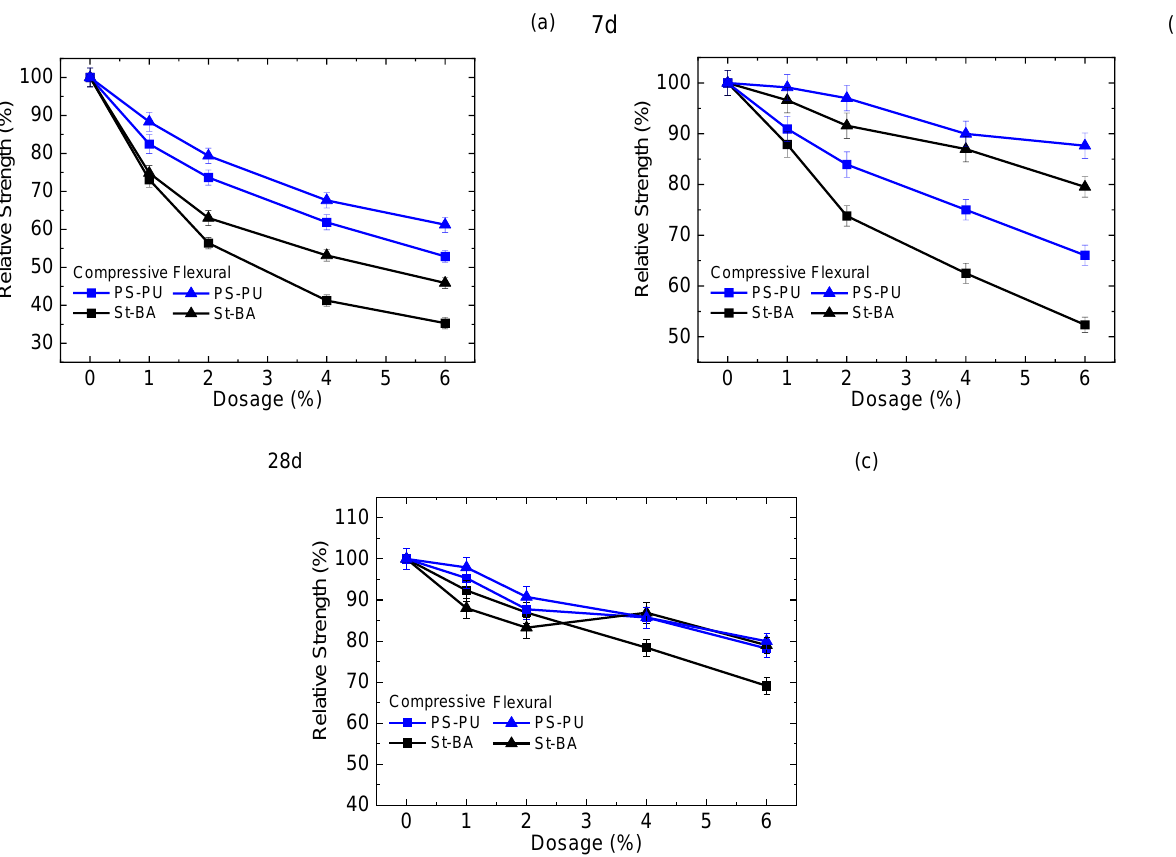
Figure 3. Strength of cement mortars with latex modification: ( a ) 1 d; ( b ) 7 d; ( c ) 28 d.